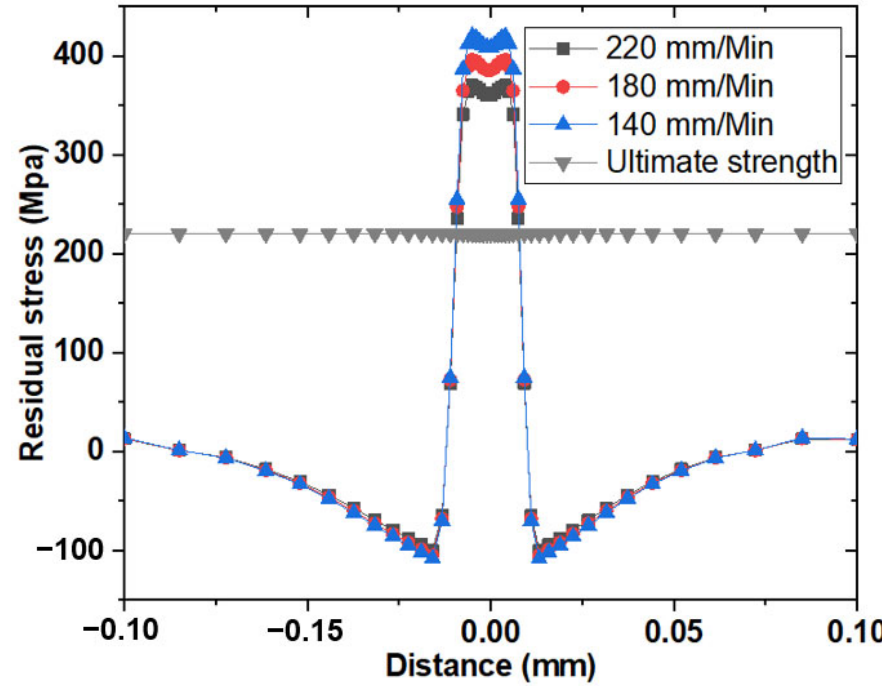
Figure 12. Residual stress along the transverse direction with different torch speed.